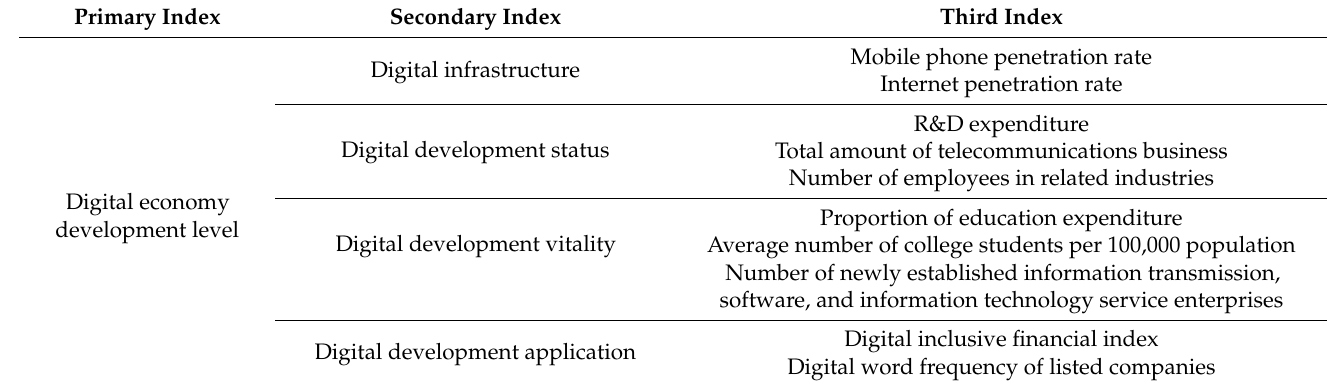
Table 1. Comprehensive index of digital economy development